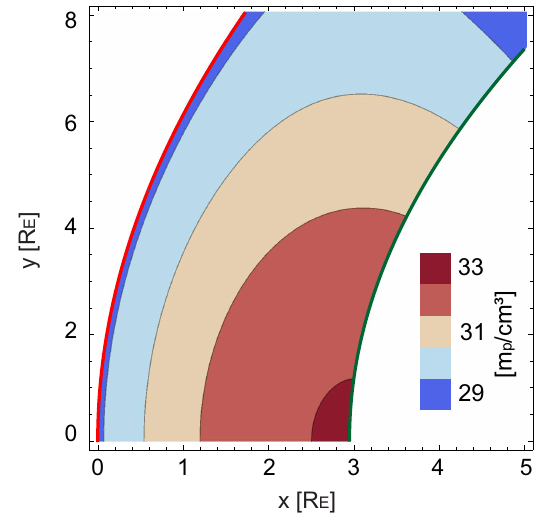
Fig. 8. Magnetosheath density distribution obtained by solving the second-order approach. The parabolic bow shock (red) and the mag- netopause (green) are